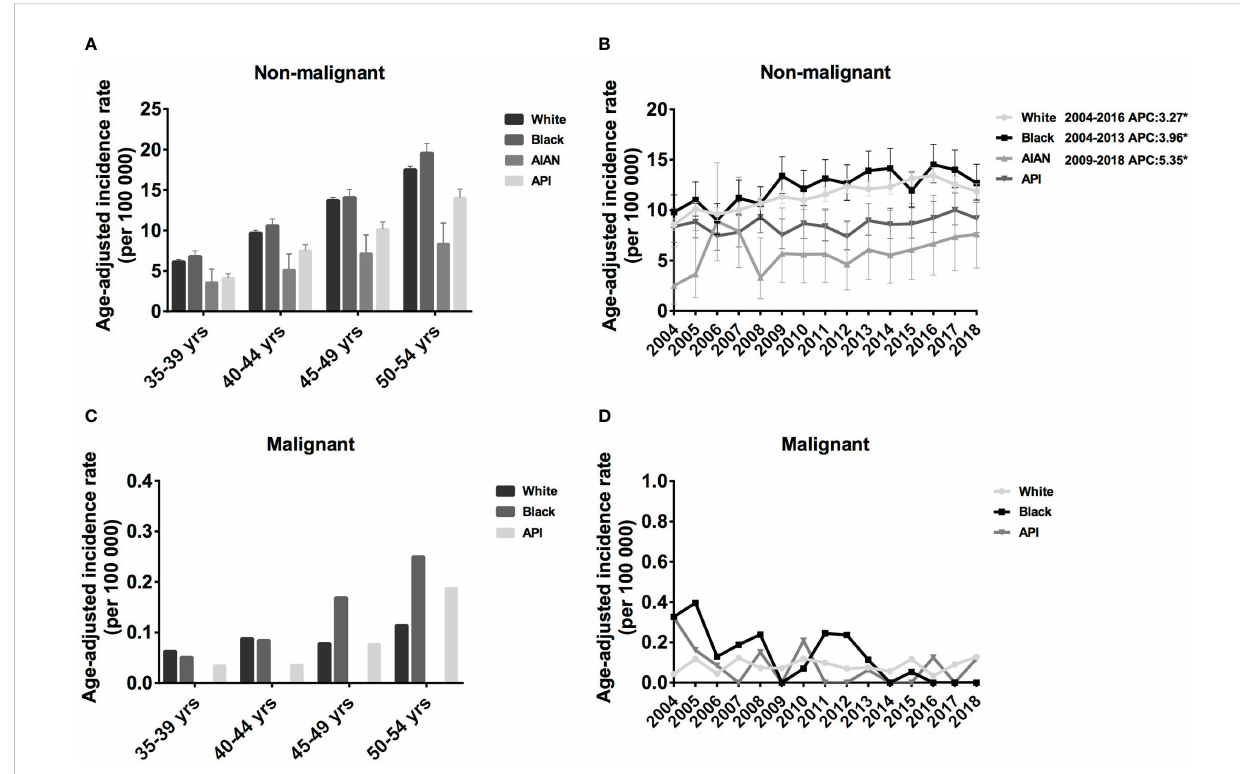
FIGURE 2 Age-adjusted incidence rates (IRs) and annual percent changes (APCs) by age and race. IRs by race and by 5-year age intervals (A, C) , APCs by race over time from 2004 – 2018 (B, D) . (A, B) , non-malignant meningioma; (C, D) , malignant meningioma. *Only show APCs that are signi fi cantly different at the P < 0.05